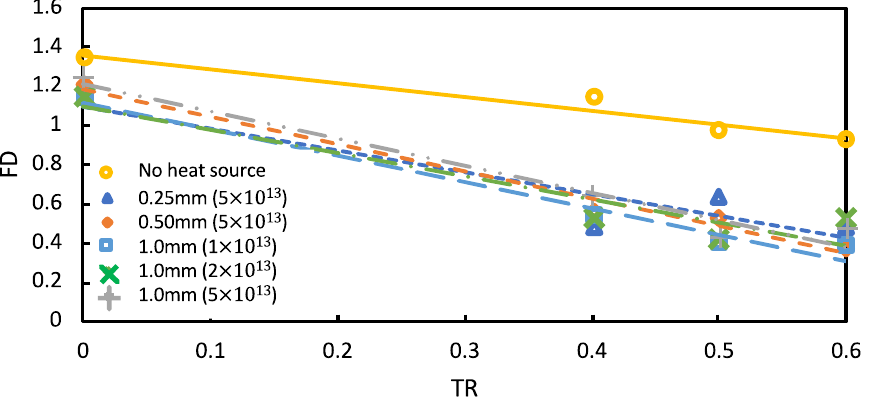
Figure 8. Flow distortion in transient conditions at various diameters and powers of heat